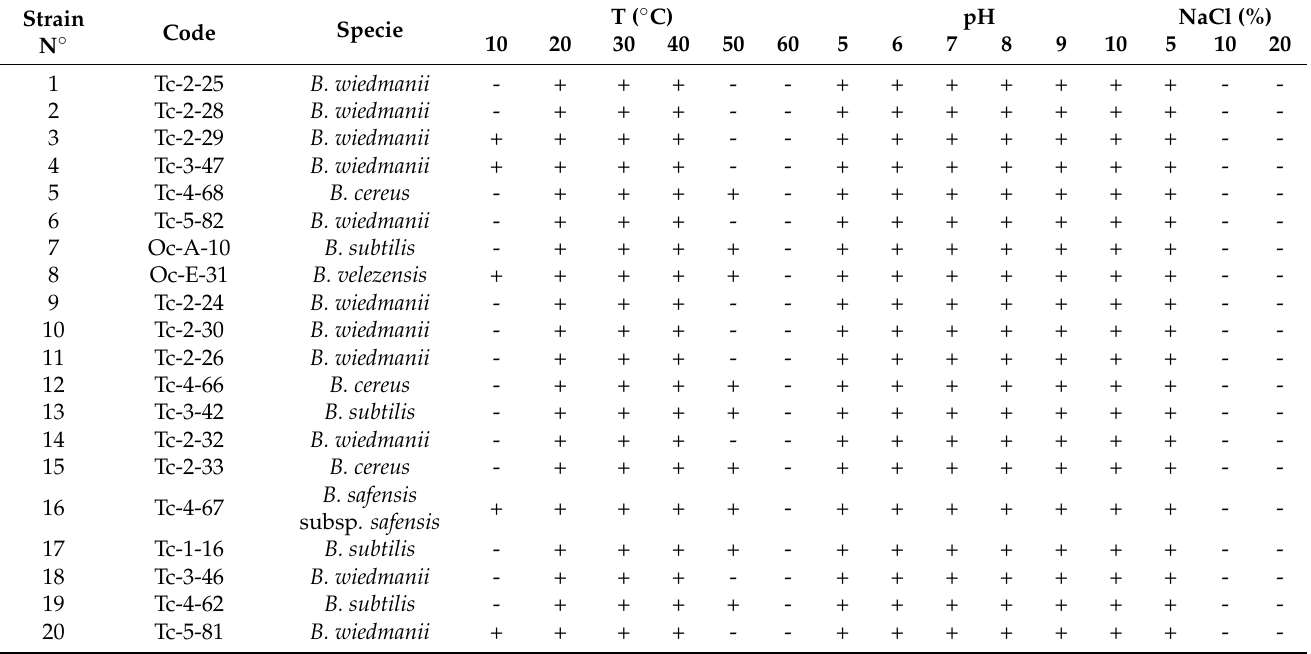
Table 2. Physiological characterization of the isolated strains regarding tolerance tests at different temperatures, pH, and NaCl concentrations.